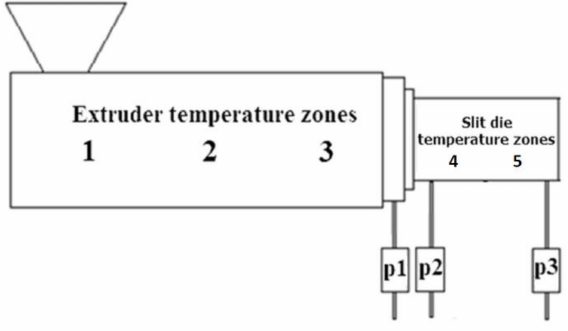
Figure 2. Scheme of the testing online